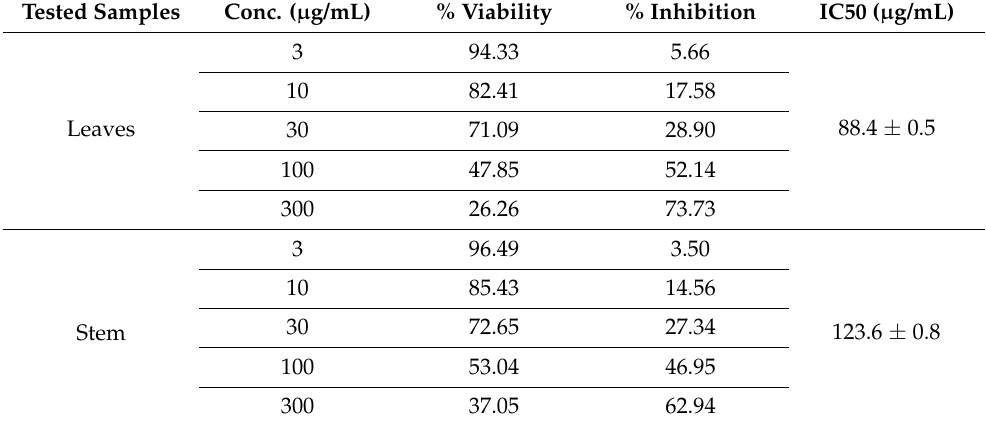
Table 2. The % viability and inhibition of B. hirtum essential oil on the breast cancer cell line MDA- MB-231.